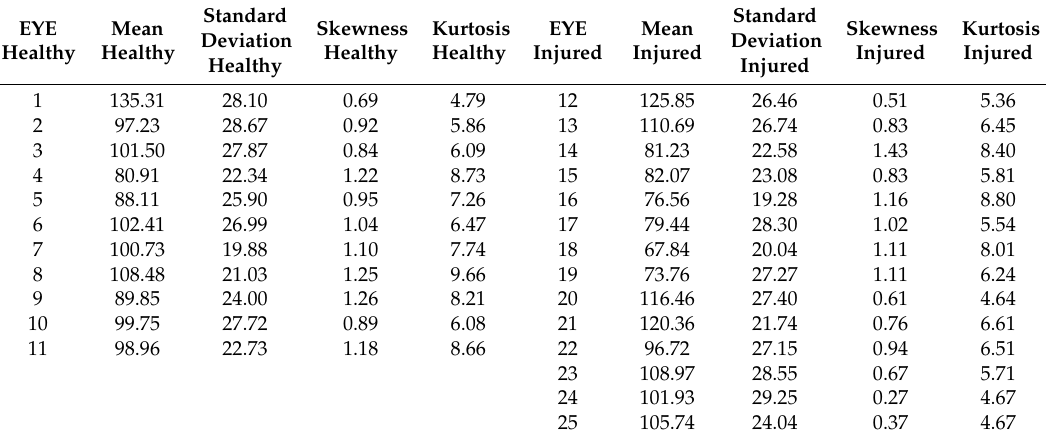
Table 3. 4-features computed from image histogram for 25